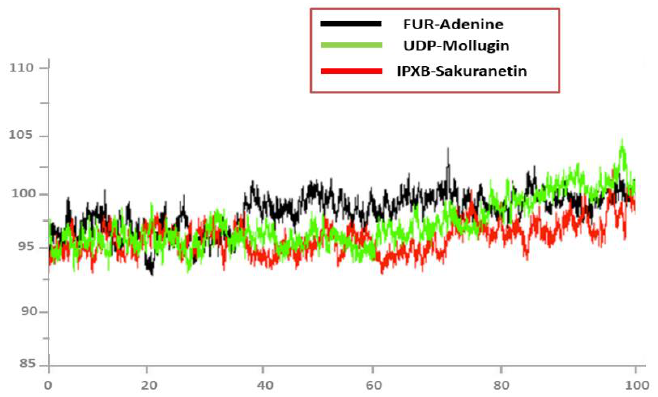
Figure 8. RoG analysis of top docked complexes.